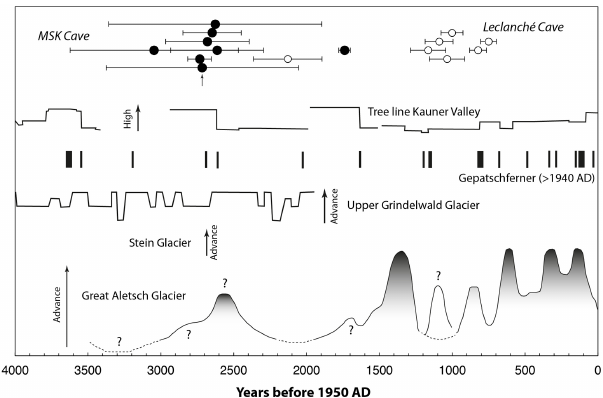
Figure 11. 230 Th dates of CCC coarse from MSK Cave (filled cir- cles) and the west-Alpine Leclanché Cave (open circles; Luetscher et al., 2013) compared to changes in the elevation of the tree line in the central-Alpine Kauner Valley (Nicolussi et al., 2005), ad- vances of the east-Alpine Gepatsch Glacier beyond the extent of the 1940AD glacier size (Nicolussi and Patzelt, 2001), a speleothem- based record of the ice surface elevation of the Upper Grindel- wald Glacier (Luetscher et al., 2011), 10 Be-dated evidence of a marked advance of Stein Glacier, Switzerland (Schimmelpfennig et al., 2014), and a semicontinuous glacier-length record of the Great Aletsch Glacier in the Western Alps (Holzhauser et al., 2005) for the last four millennia. The only date of the white crystal fraction from MSK Cave is marked by a small vertical